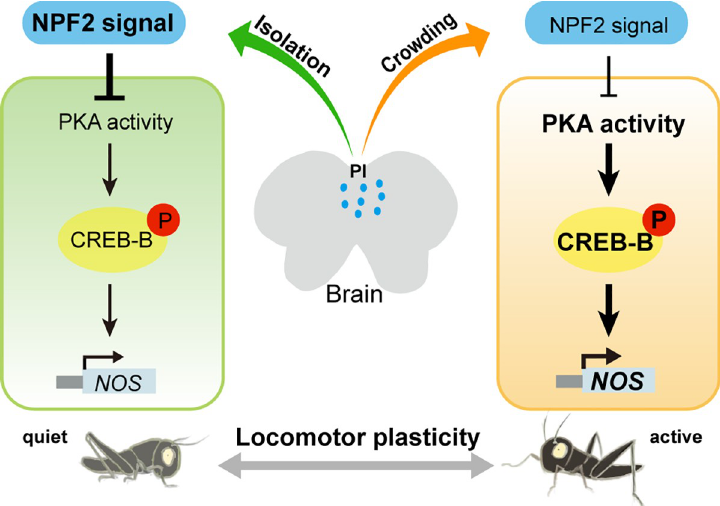
Fig 8. Schematic representation of NPF2/PKA/CREB-B/NOS signaling cascade in the modulation of locomotor plasticity in the locust. During isolation, the up-regulation of NPF2 signal suppresses the NOS transcription by inhibiting CREB-B phosphorylation catalyzed by PKA, thus reducing locomotor activity. Upon crowding, the down- regulation of NPF2 signal promotes PKA activity, which in turn activates CREB-B phosphorylation and NOS transcription and consequently enhanced locomotor activity. Blue dots in the locust brain indicate NPF2 localization. Bold indicates increased levels or activity.